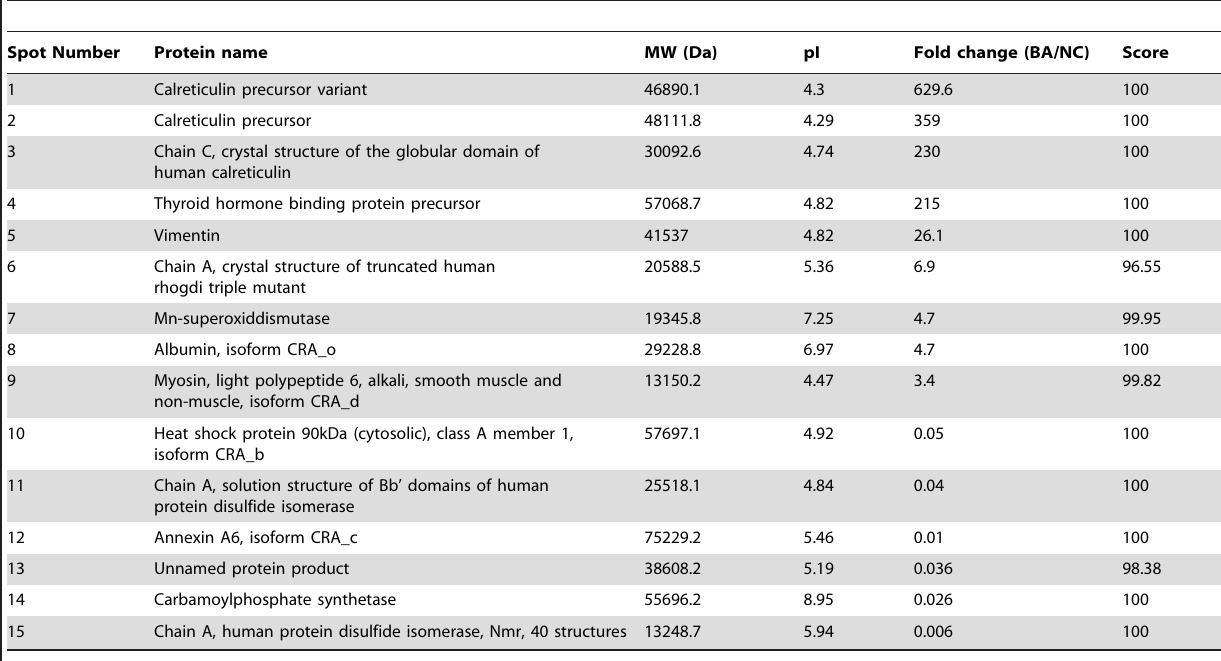
Table 2. Differentially expressed proteins identified by MALDI-TOF-MS in liver biopsy samples from BA and NC patients.